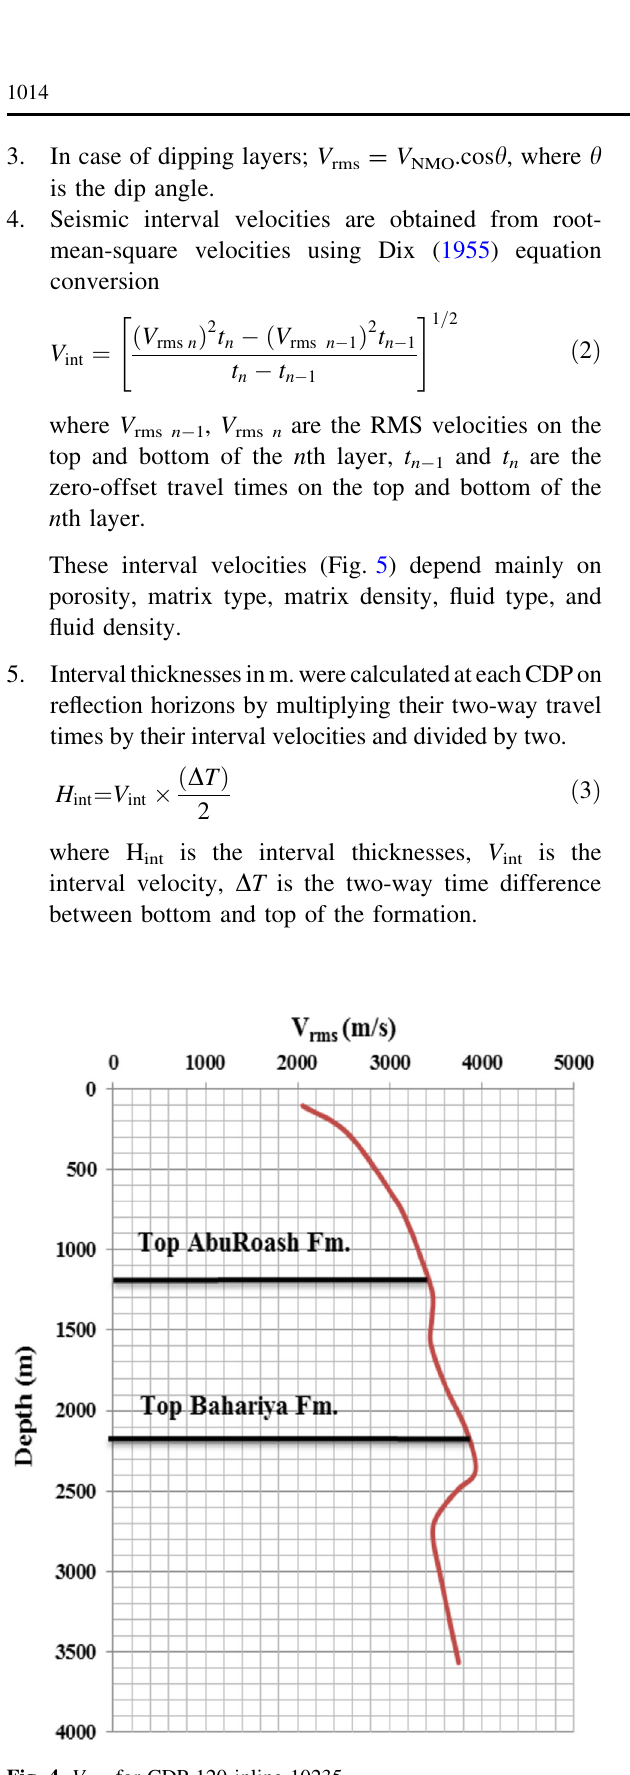
Fig. 4 V rms for CDP 120 inline 10235